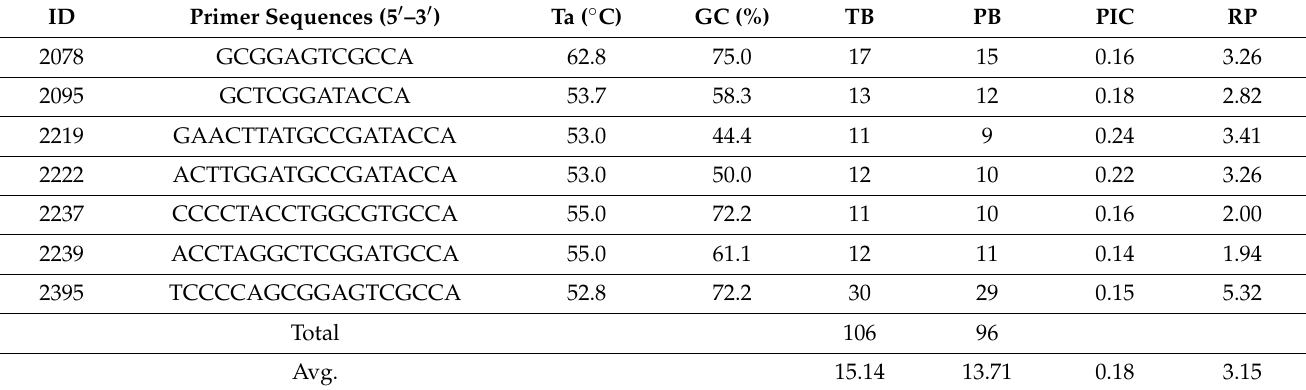
Table 1. The information of PBS primers used to evaluate Rhizoctonia spp.